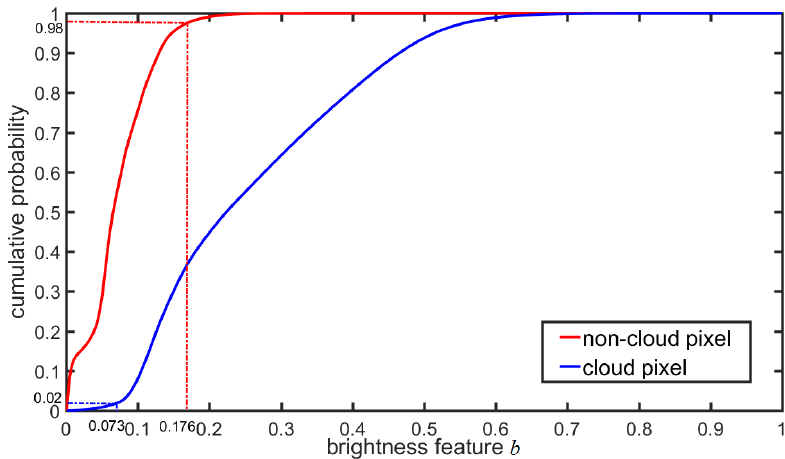
Figure 3. Cumulative histogram of brightness feature b